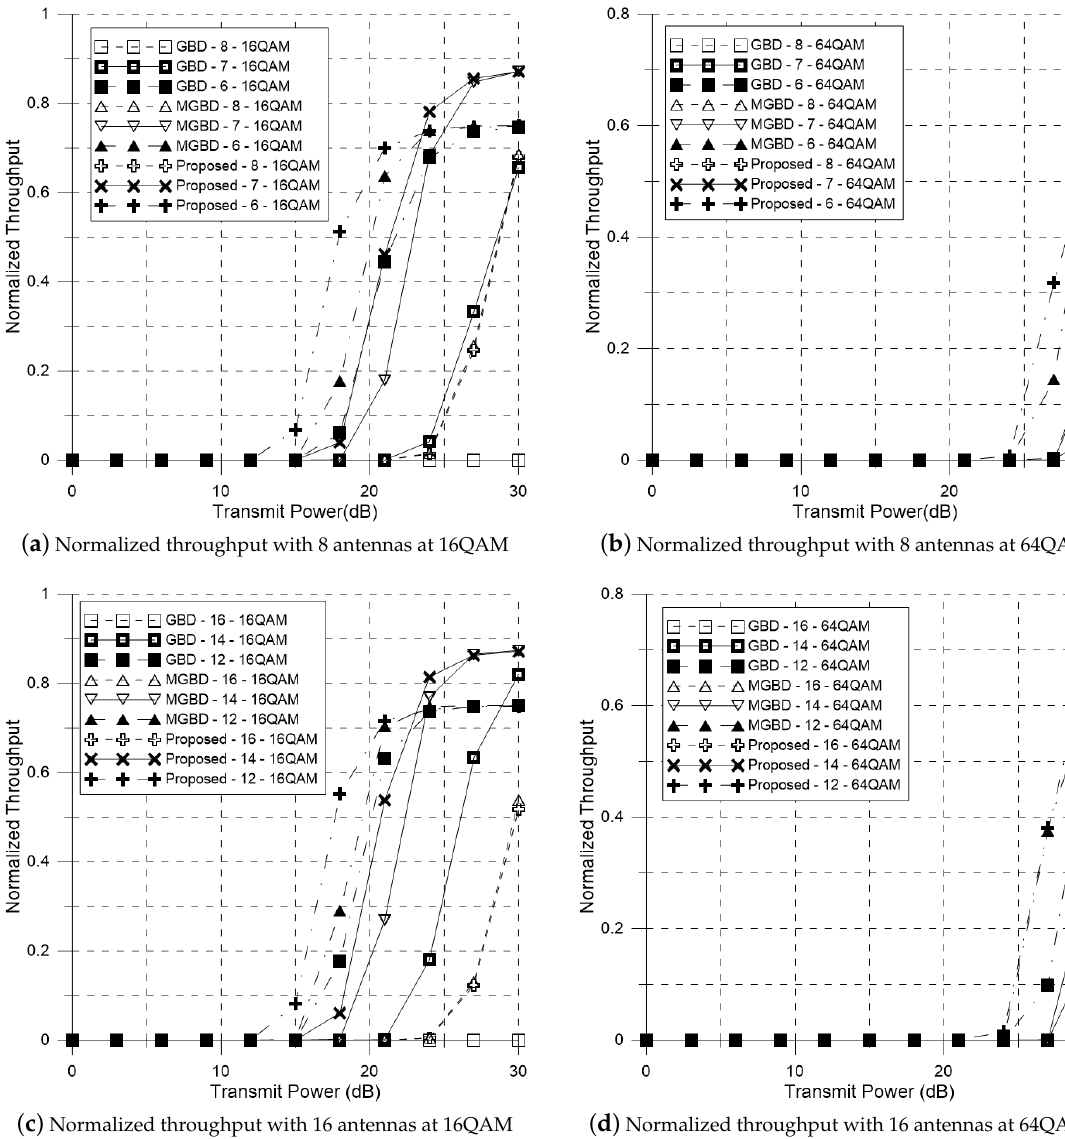
Figure 8. Normalized throughput performance of GBD, MGBD and proposed